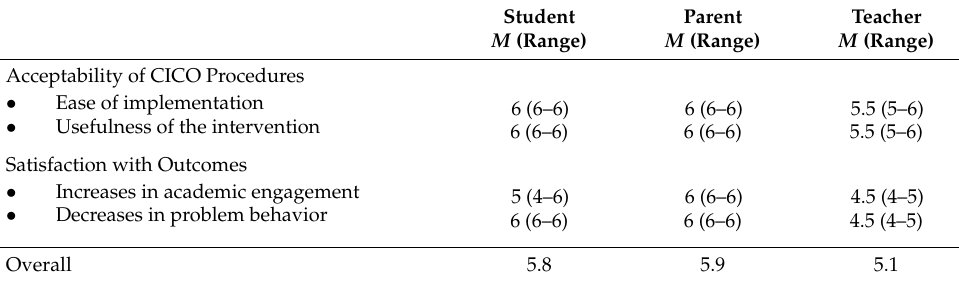
Table 1. Summary of social validity data by each